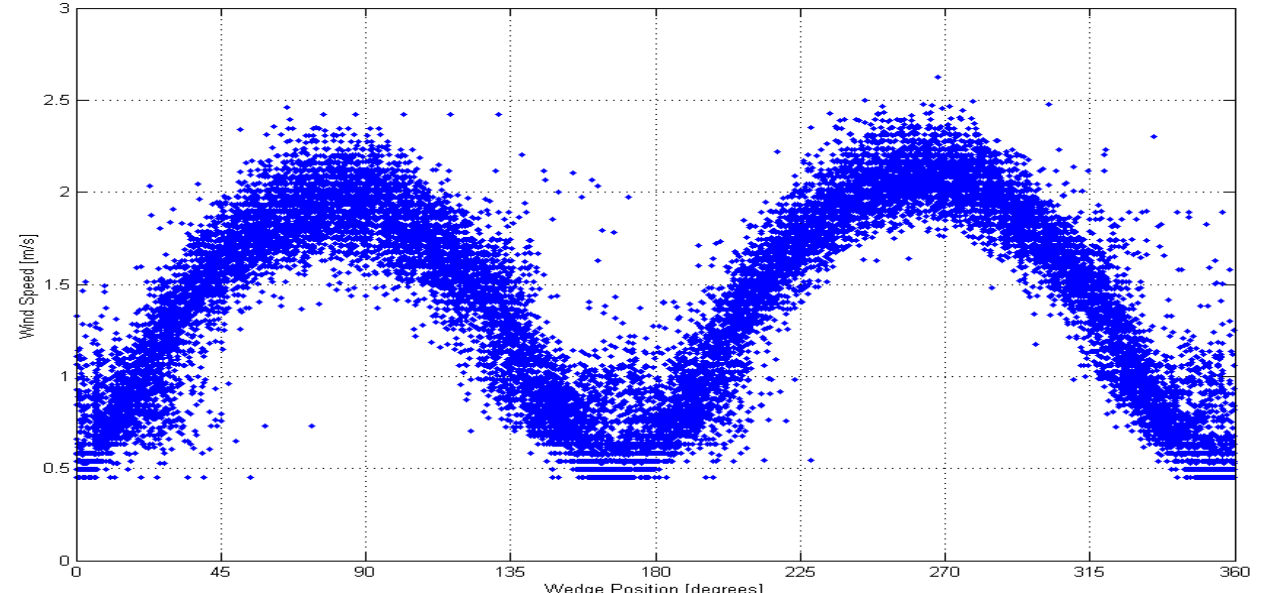
Figure 8. Line-of-sight velocity determined with a LIDAR unit as a function of the azimuth angle [30]. Reproduced with permission